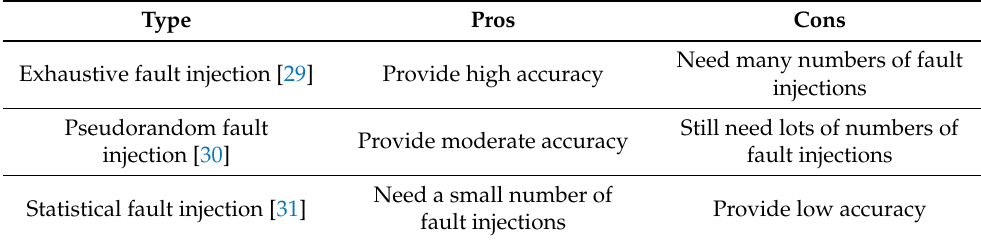
Table 1. Various fault injection approaches.